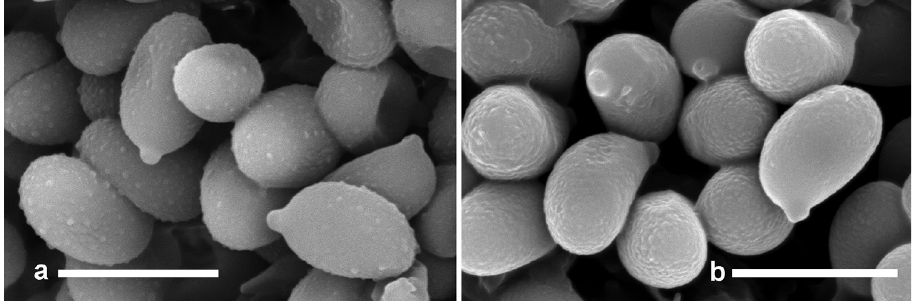
Figure 5. SEM of basidiospores of Xanthagaricus spp. a SEM basidiospores of X. flavosquamosus (GDGM 50918, holotype) b SEM of basidiospores of X. necopinatus (PHI-12, isotype). Scale bars: 5 μm.